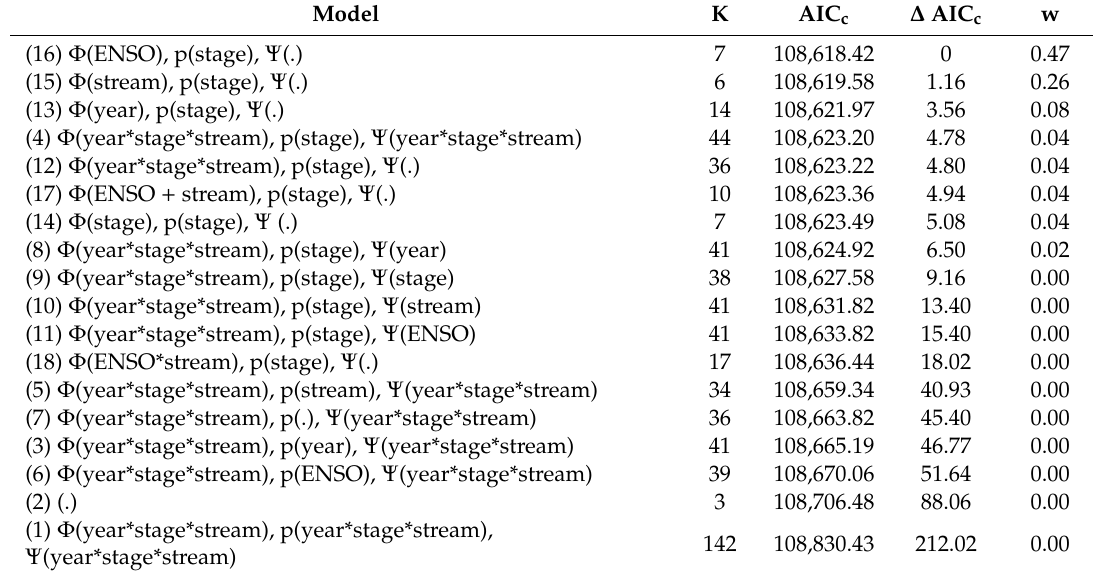
Table 1. Rankings of multi-state models estimating survival ( Φ ), recapture (p), and transition ( Ψ ) probabilities for the Chocoan River Turtle on Isla Palma. AIC c = Akaike information criterion corrected for small sample sizes; K = number of parameters; w = AIC c weight; El Niño–Southern Oscillation (ENSO) = phases (La Niña, Neutral, El Niño); stages = hatchlings, juveniles, and adults; type of stream = muddy, rocky. Models are ranked based on AIC c . The order in which the models were computed is shown in